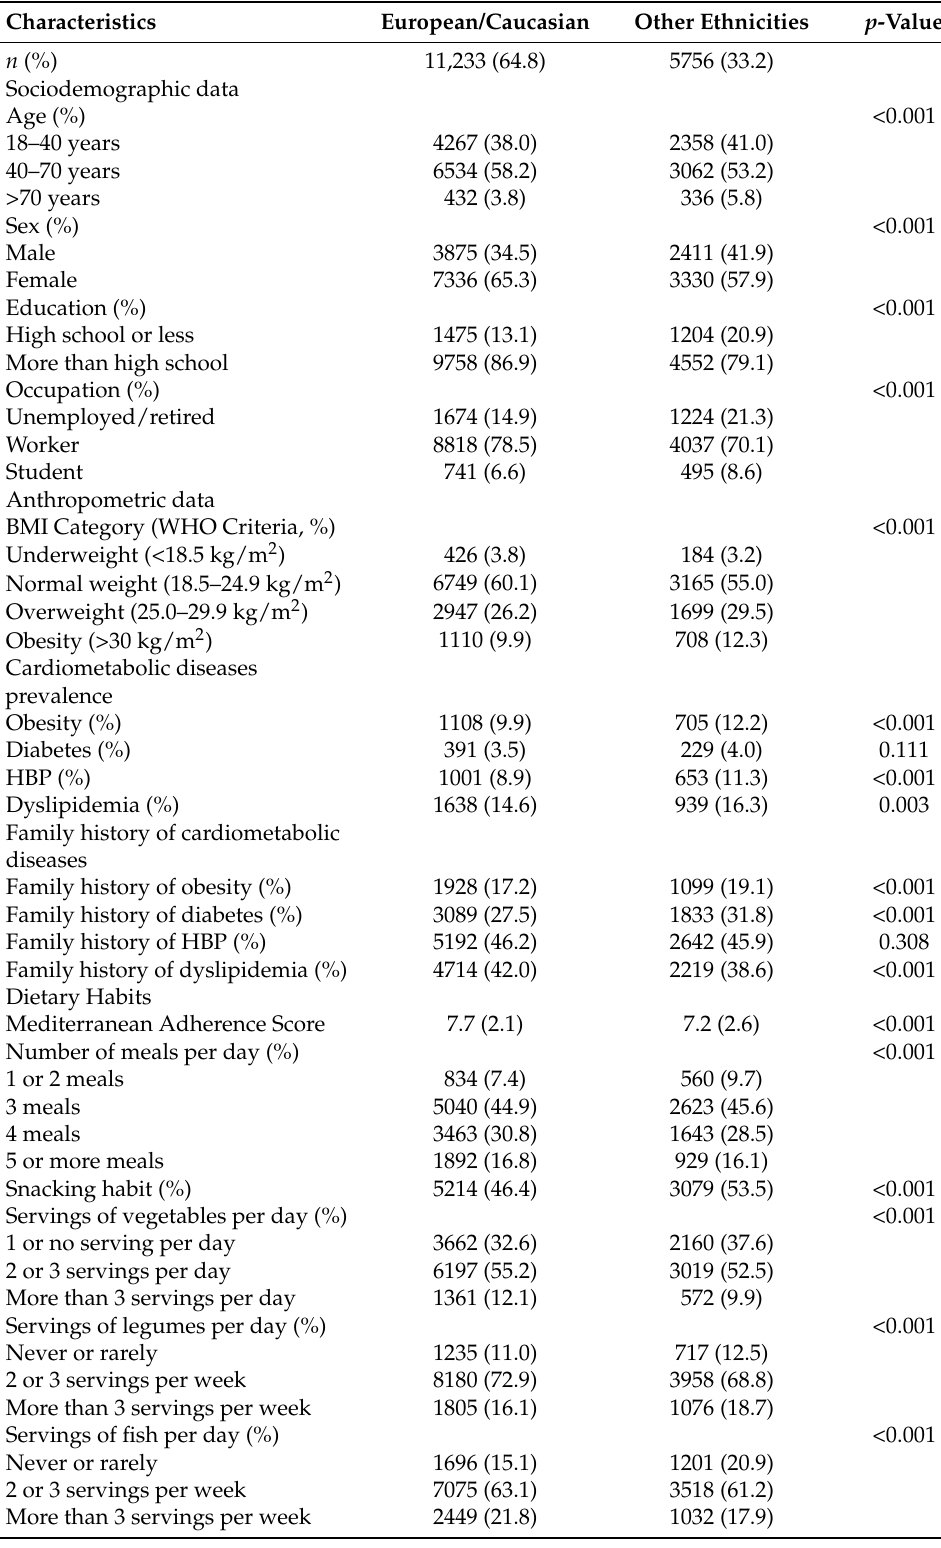
Table 3. Sociodemographic Data, Health Characteristics, Dietary Habits, Lifestyle and Quality of Life Features of the participants Categorized by Ethnicity (European/Caucasian and other